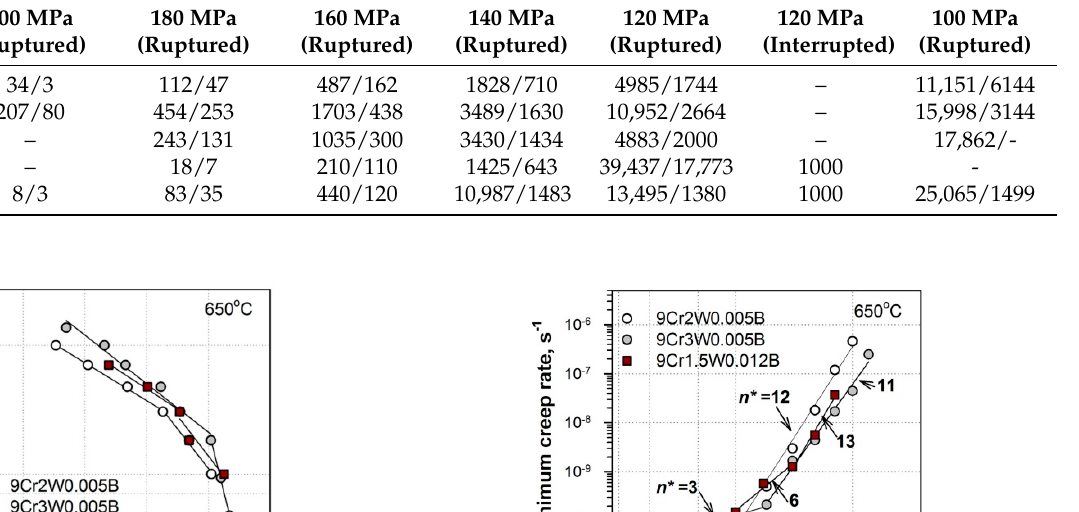
Table 3. Effect of applied stresses on rupture time (numerator) and off-set time (denominator), at which minimum creep rate is achieved, and an information on durations of interrupted creep tests at 650 ◦ C (in hours).